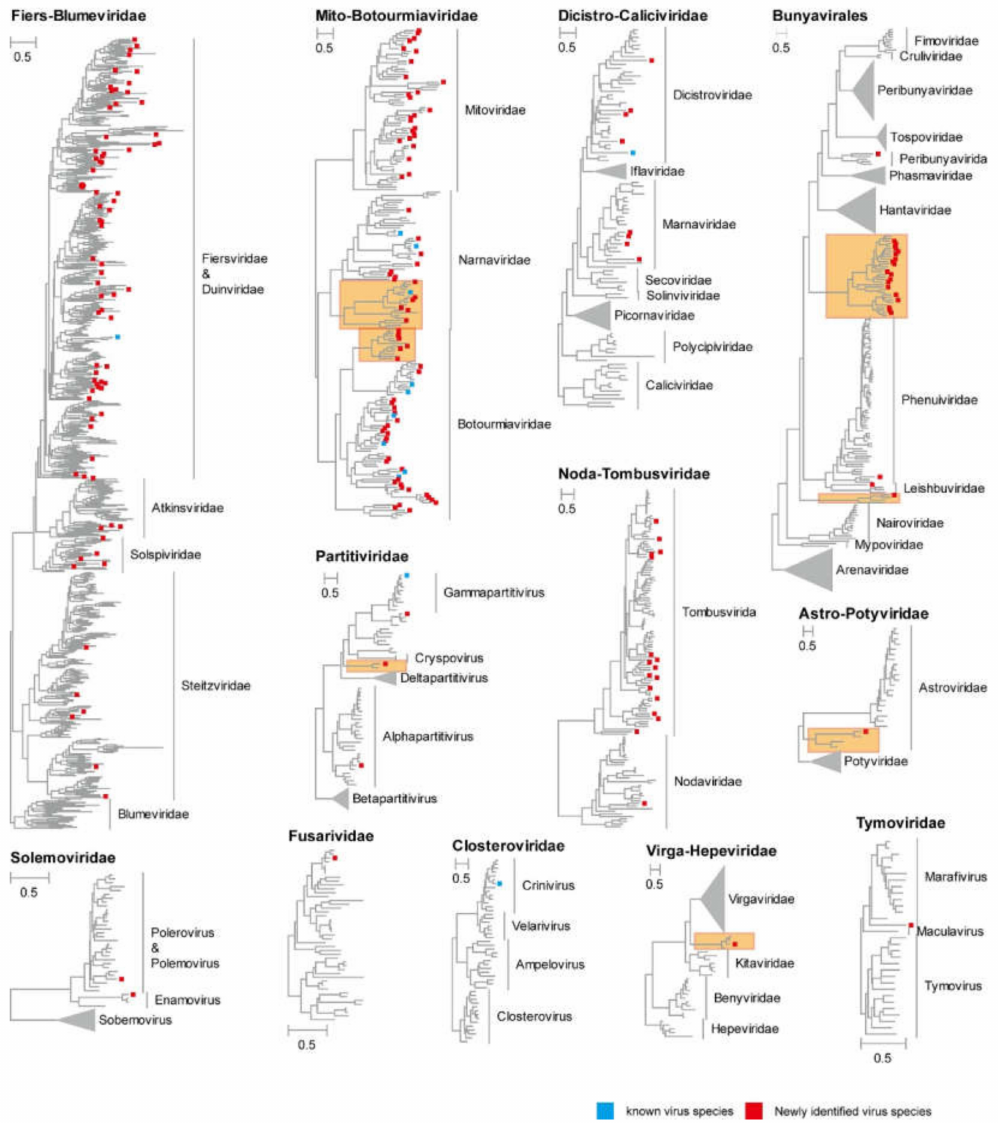
Figure 2. Phylogenetic diversity of RNA viruses identified in this study. Phylogenetic trees were constructed using the aligned sequences of RdRp. The name of each tree is shown to the top left of each phylogeny. Within each tree, the names of new viruses discovered in this study are marked with a red square, the names of known viruses discovered in this study are marked with a blue square and the families and genera of viruses (and branches in minimized trees) obtained in this study are marked in bold. Potential new families or genera are indicated with orange